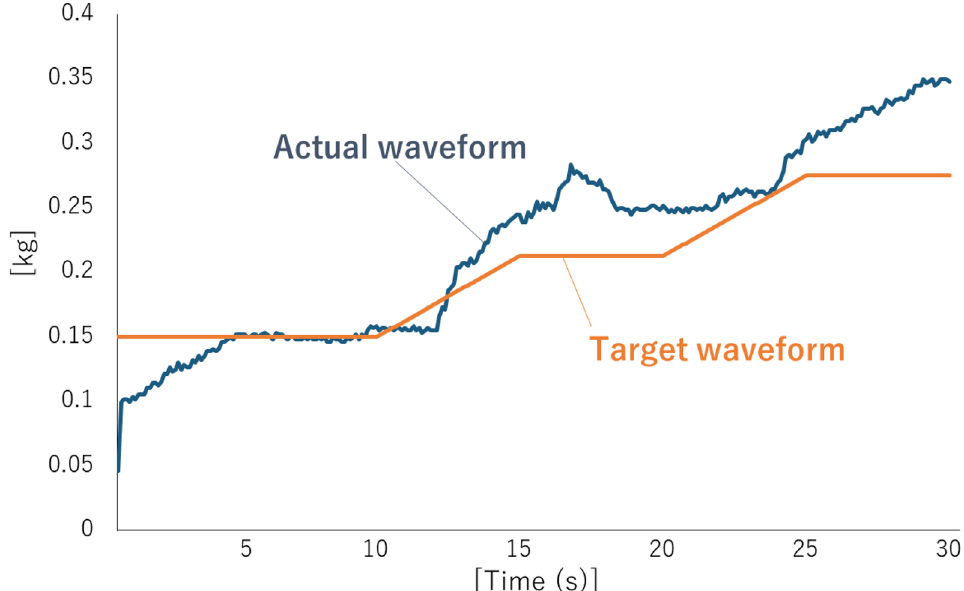
Figure 3. Waveforms of the main learning task and feedback screen. This is the waveform of an individual participant in the young adult